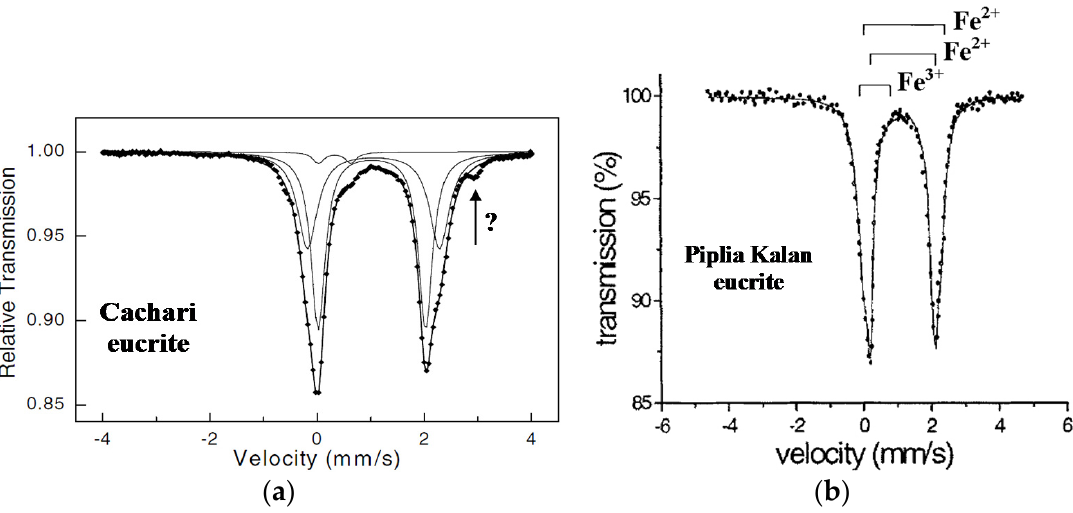
Figure 5. Comparison of the room temperature Mössbauer spectra of Cachari ( a ) and Piplia Kalan, lithology A ( b ) monomict eucrites. Indicated spectral components are the results of the fits. Adapted from [11,19].